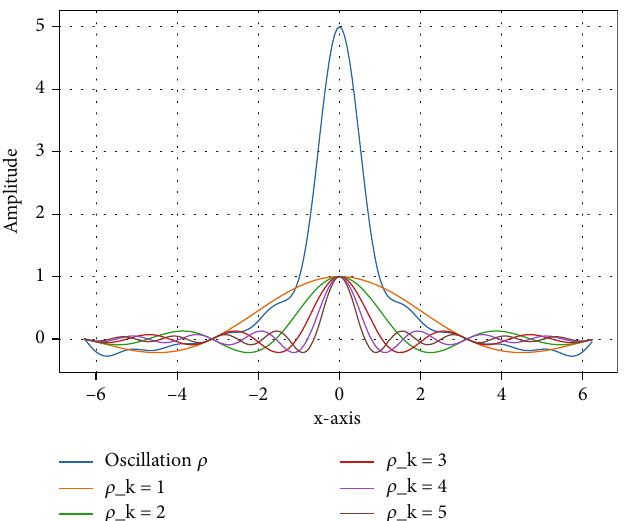
Figure 3: This fi gure shows the oscillation ρ ð r , t Þ = ∑ n =5 A ð n Þ sin ð n · k ′ r Þ cos ð n · k ′ c t Þ / r centred at the origin of the coordinates at time s ,0 n =1 = 1 . Oscillation ρ represents the oscillation of 5 spherical standing waves t = 0 in the range r ∈ ð 0, 2 π Þ . With A ð n Þ = 1/ nk ′ , k ′ = 1 , c s ,0 superimposed. ρ is the oscillation of 5 individual spherical standing waves centred at the origin with A ð n Þ and di ff erent wave number k = i k = nk ′ = i , respectively.